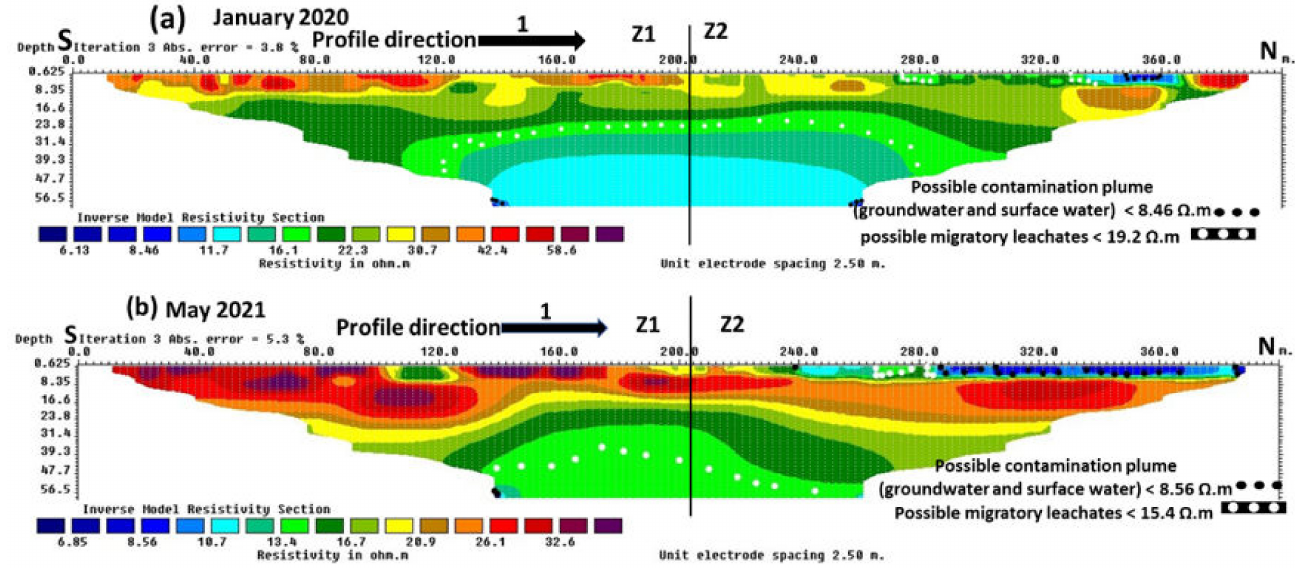
Figure 2. Electrical resistivity model of profile 1, 2020, ( a ) and 2021 ( b